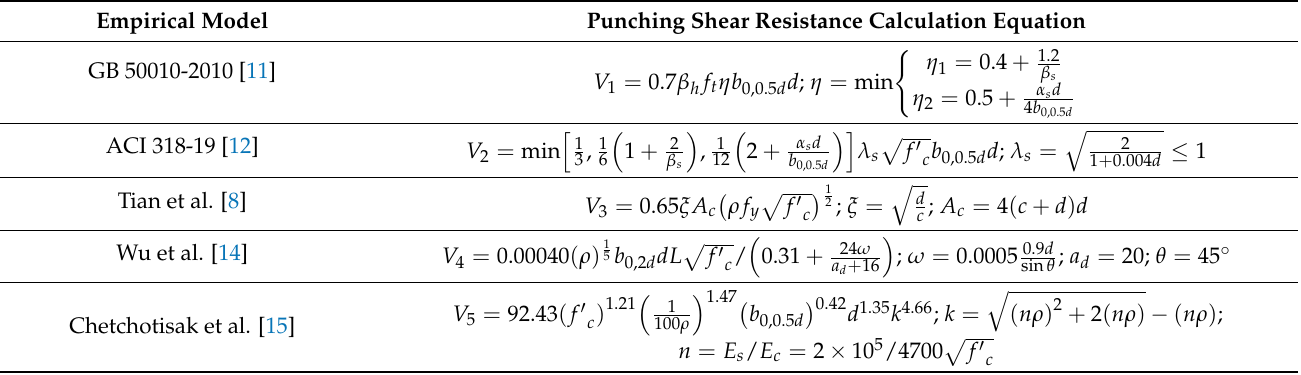
Table 3. Empirical models used for prediction performance comparison.